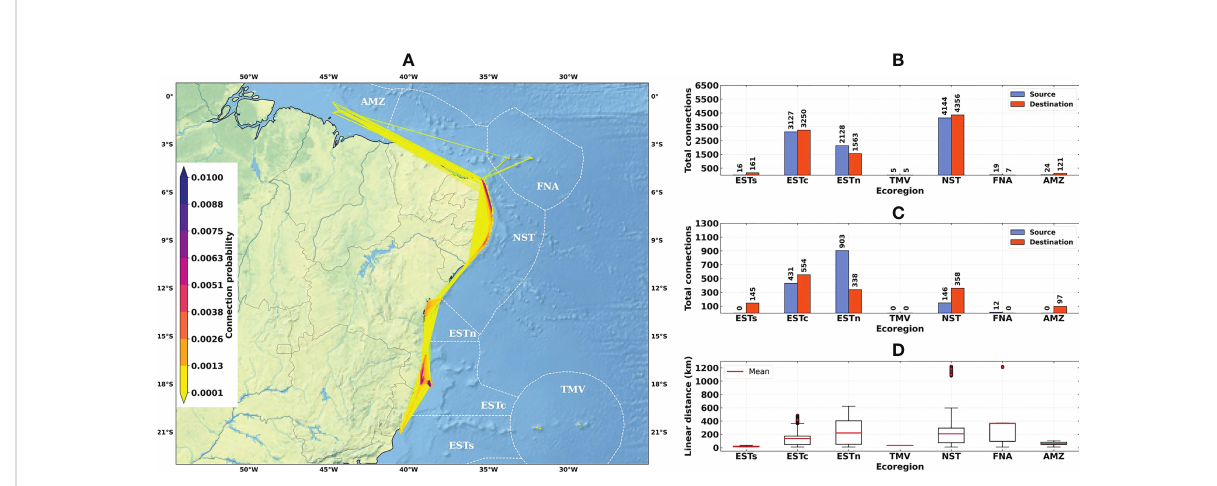
FIGURE 4 Connectivity patterns obtained from the larval connectivity model, considering the average of dispersal simulations between August – September – October for the 1993 – 2019 time-series: (A) Distribution of connection probabilities between reef sites; (B) Total number of connections given source (in blue) and destination (in orange) ecoregions; (C) Number of connections given source (in blue) and destination (in orange) ecoregions, disregarding connections between reef sites within the same ecoregion; (D) Linear distances from connections between the source and destination reef sites. Ecoregions: Eastern-south (ESTs); Eastern-center (ESTc); Eastern-north (ESTn); Northeastern (NST), Amazon (AMZ), Fernando de Noronha-Atol das Rocas (FNA), Trindade-Martim Vaz Islands